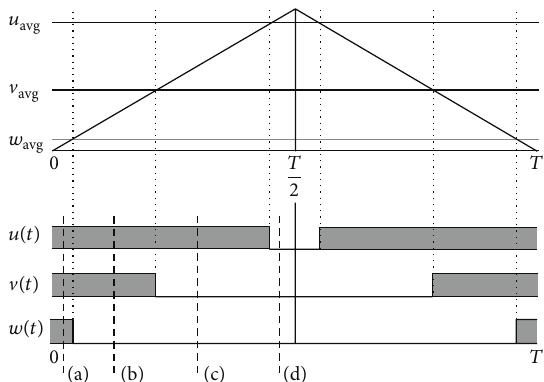
Figure 9: General structure of sequence